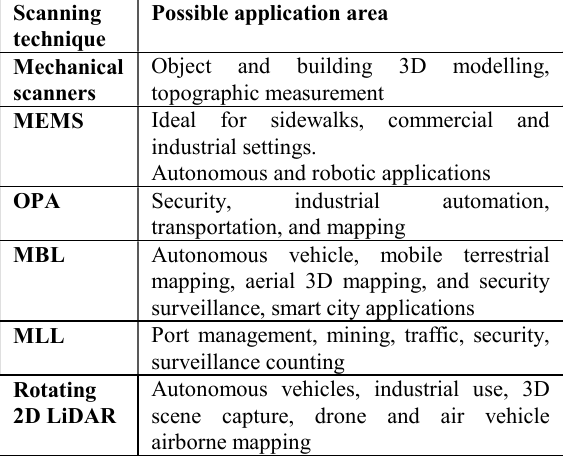
Table 6. A possible application area for laser